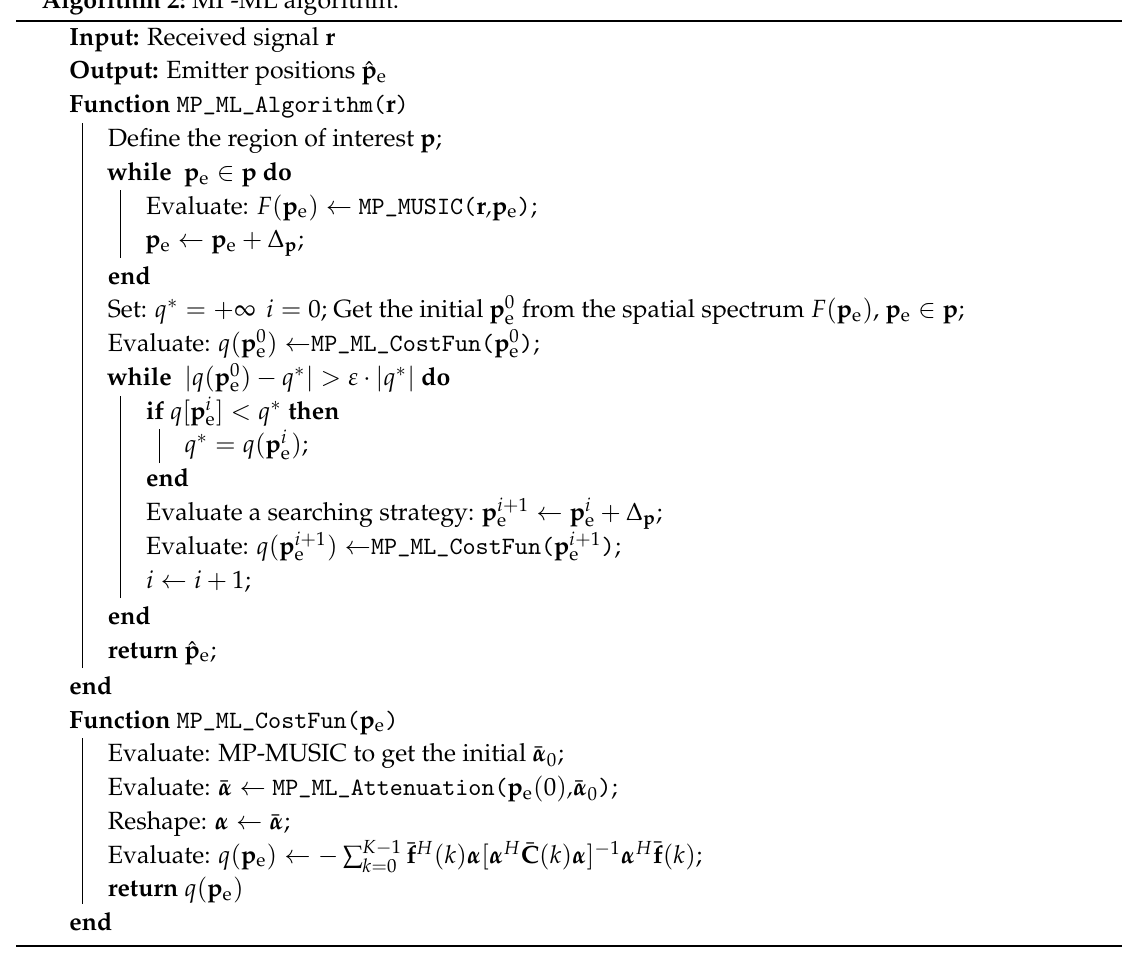
Algorithm 2: MP-ML